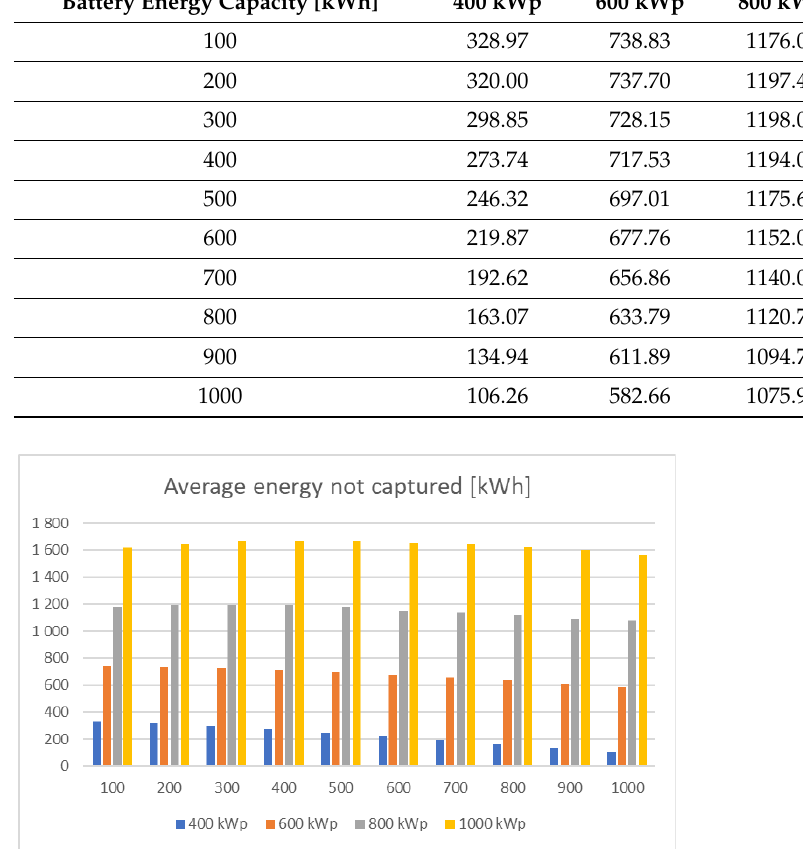
Table 4. Average daily amounts of not captured energy for PV installations from 400 to 1000 kWp for different battery energies from 100 to 1000 kW.